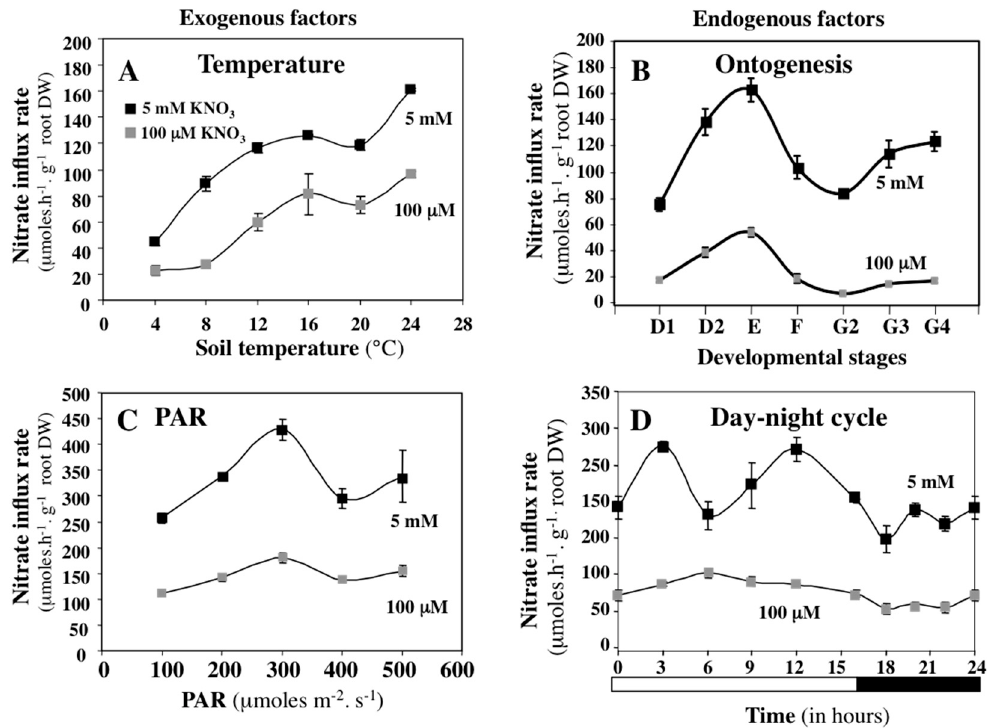
Figure 6. Effects of changes in exogenous and endogenous factors on 15 NO 3 − influx rates of B. napus plants at 100 μ M and 5 mM external nitrate concentrations. ( A ) Effects of temperature. ( B ) Effects of the developmental stage during the ontogenetic cycle. D1 to D2 inflorescence formation, F1 to G2 flowering and G3 to G4 pod formation according to the phenological calendar established by the Bayer, BASF, Ciba, and Hoechst companies. ( C ) Effects of the photosynthetically active radiation (PAR). ( D ) Effects of day–night cycle. Vertical bars indicate ± SD for N = 3 repetitions when larger than the symbols (adapted from [19]).